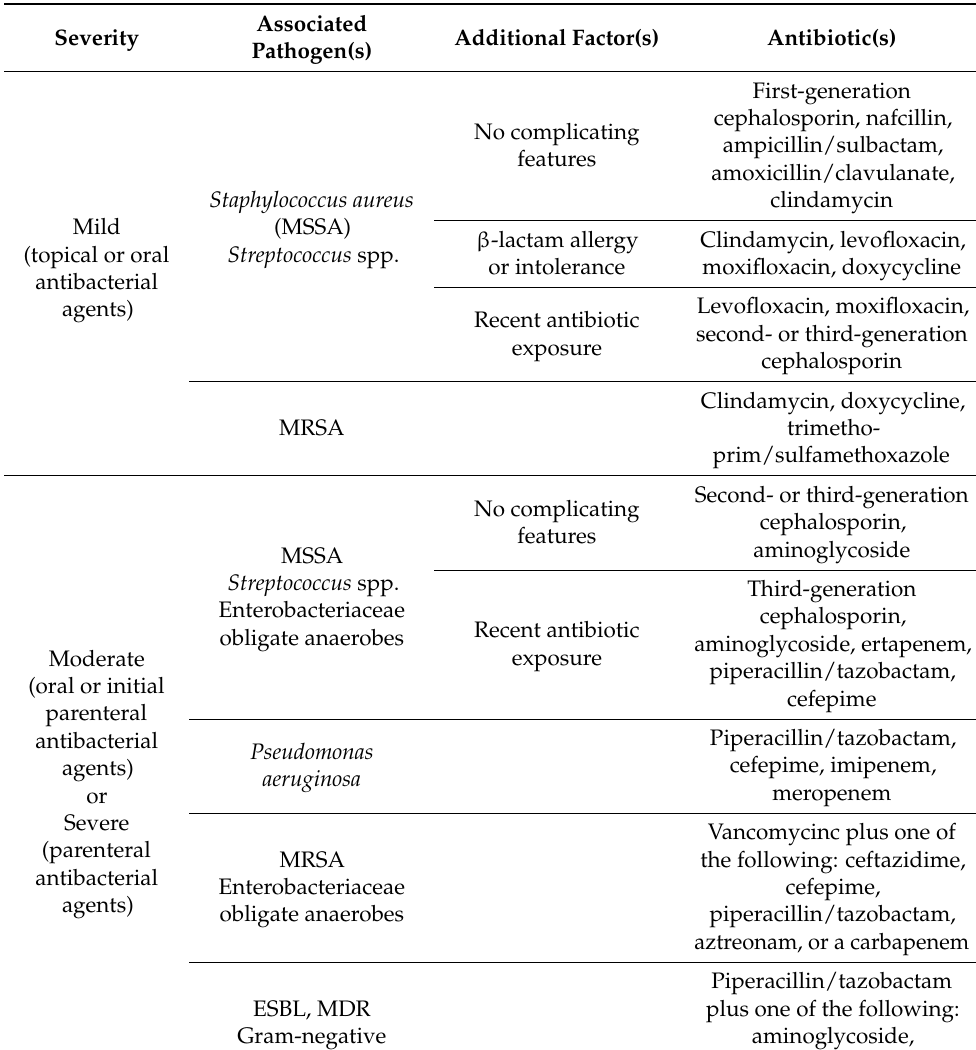
Table 1. Suggested antibiotics for the empirical treatment of infected DFUs based on the clinical severity. Adapted from Lipsky et al.